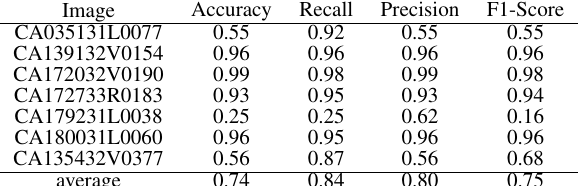
Table 2. Results of model per image